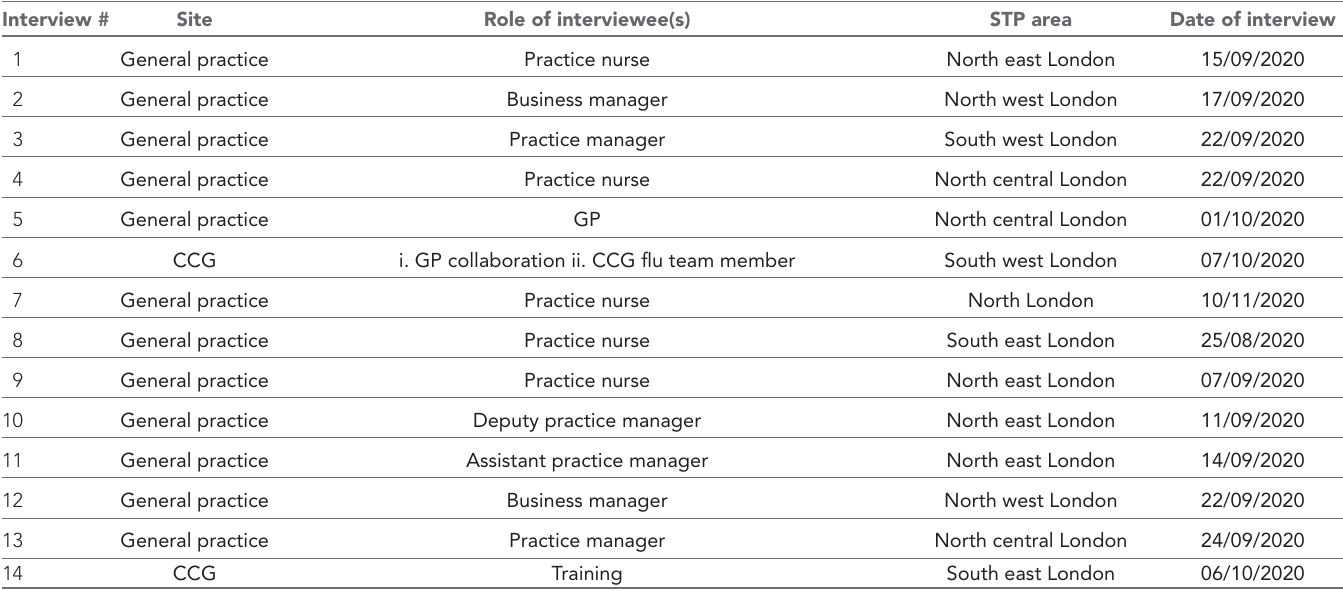
Table 1 Semi- structured interviews: location and interviewee